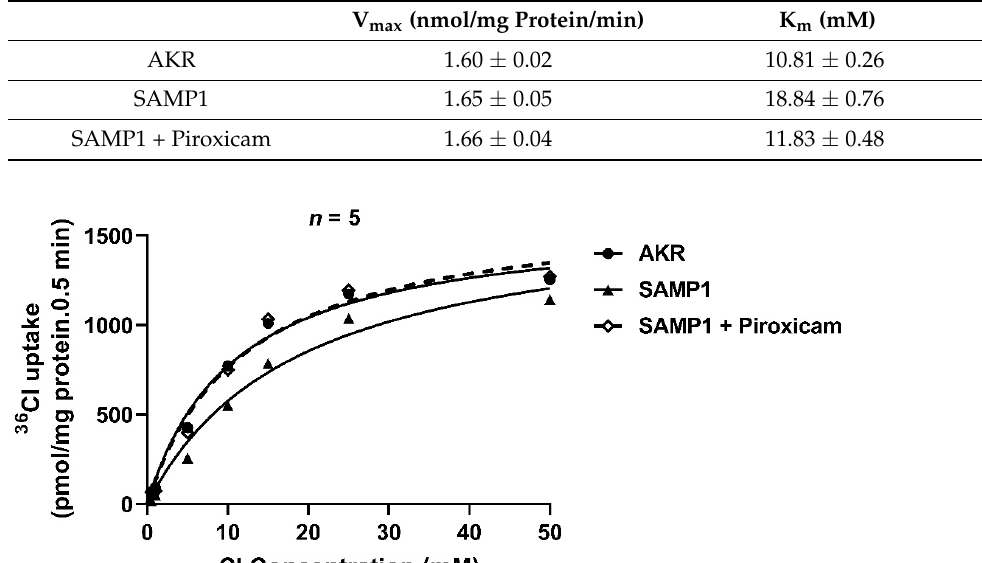
Table 1. Kinetic parameters for Cl − /HCO 3 − exchange. The affinity (1/K m ) of Cl − /HCO 3 − exchanger for substrate (Cl − ) was significantly decreased in the villus cells from SAMP1 mice compared to the control. The decrease in affinity was completely restored to normal in the villus cells obtained from piroxicam-treated SAMP1 mice.